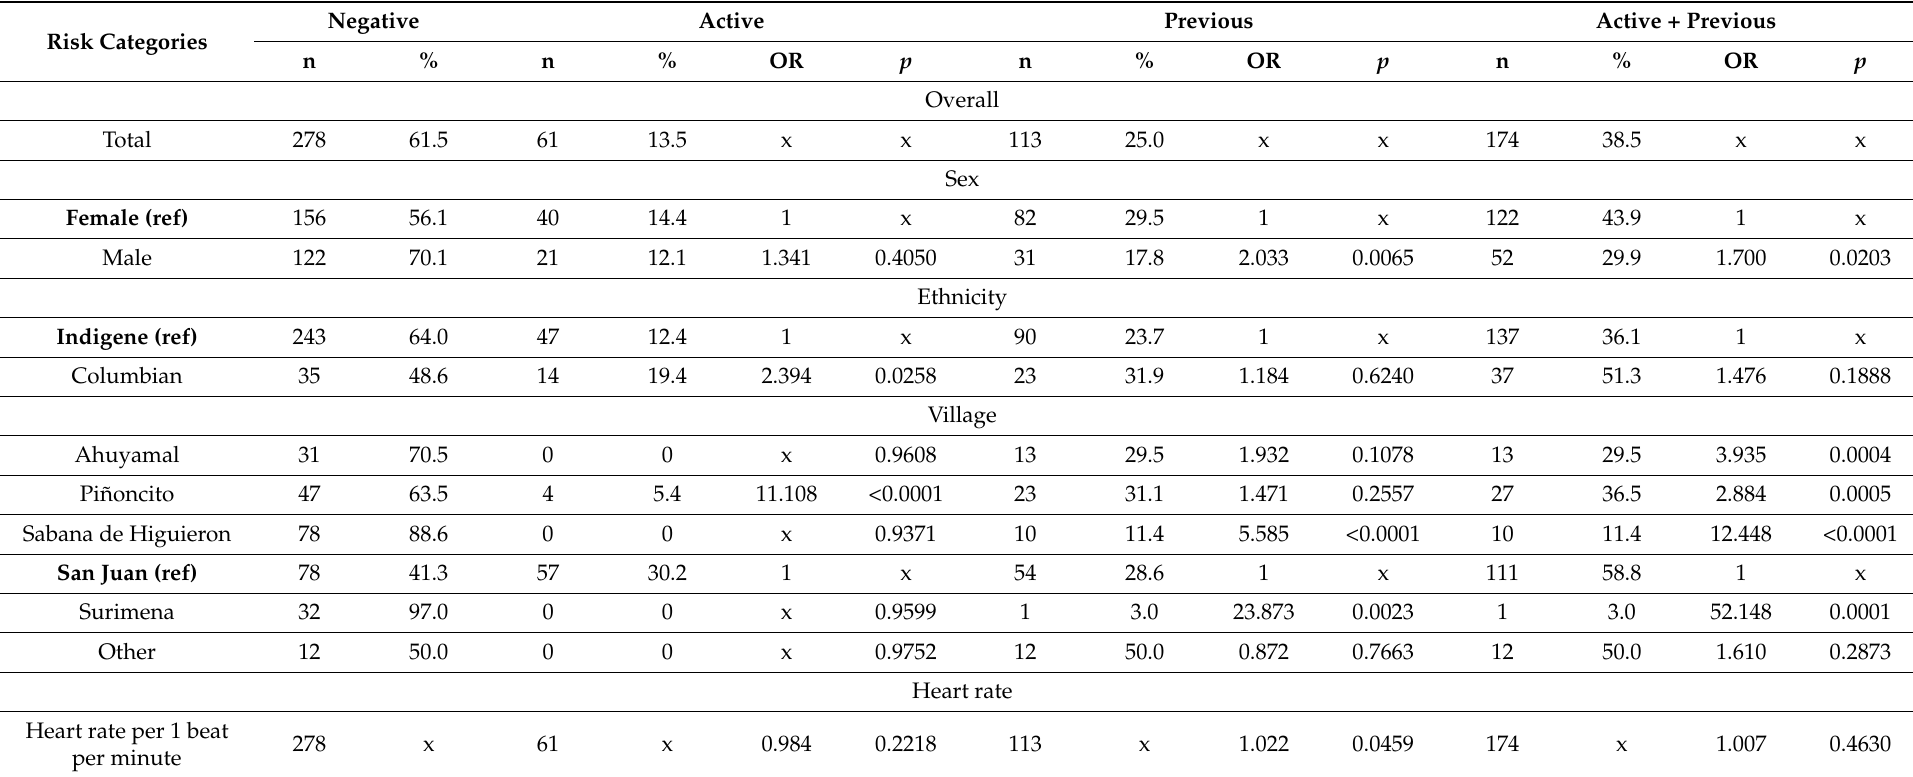
Table 3. SARS-CoV-2 status by risk categories—results of multivariable logistic regression analyses (all statistical tests within the logistic regression were compared with the negative SARS-CoV-2 tests; for factors comparing groups the reference category is marked in